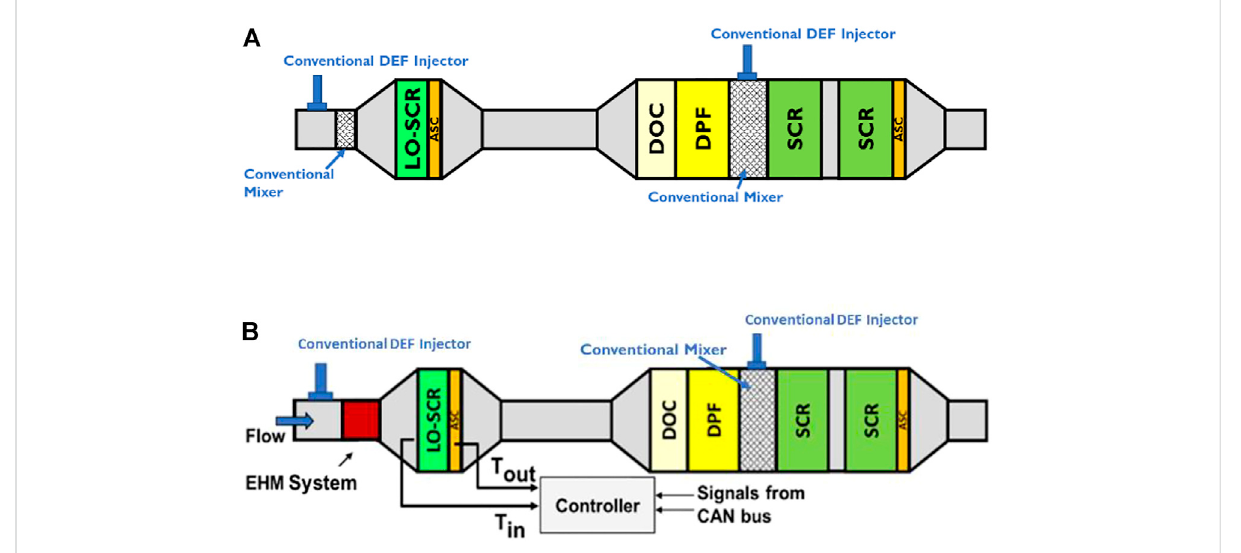
FIGURE 2 (A) Baseline aftertreatment system architecture with LO-SCR positioned close to the engine. (B) Aftertreatment system architecture with conventional DEF dosers and EHM system.